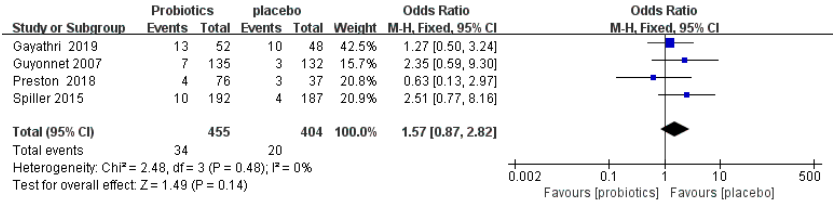
Figure 8. Effect of probiotics on incidence of adverse events in IBS-C patients. The green block represents the effect sizes of individual studies, black diamond block represents the combined effect size.